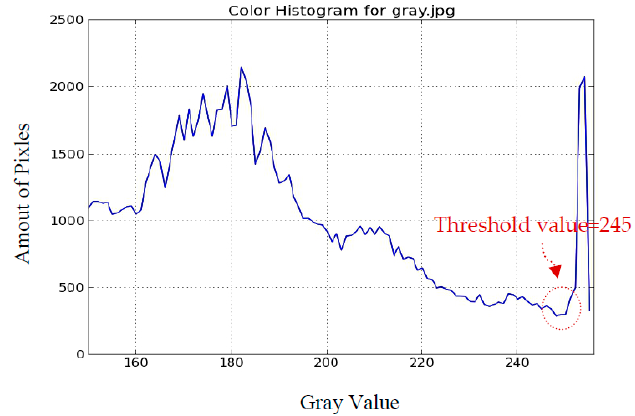
Figure 7. The histogram of Figure 1.